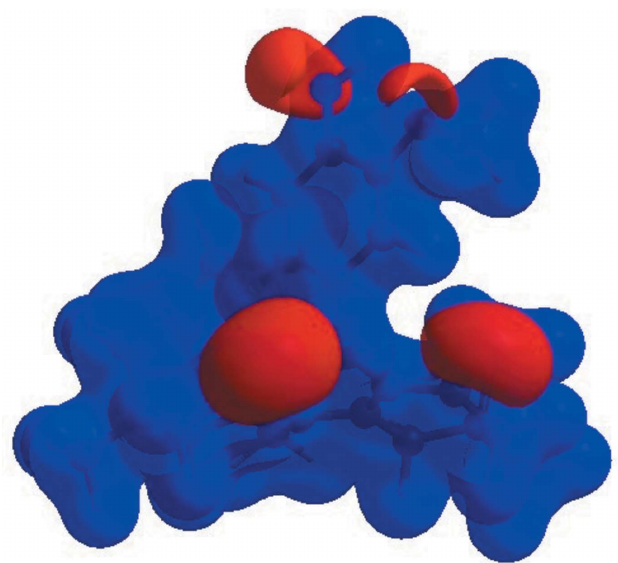
Figure 4 View of the three-dimensional Hirshfeld surface of the title molecule plotted over electrostatic potential energy in the range (cid:3) 0.0500 to 0.0500 a.u. calculated with the STO-3 G basis set at the Hartree–Fock level of theory. The hydrogen-bond donating and acceptor areas are viewed as blue and red regions, respectively, around atoms, corresponding to positive and negative